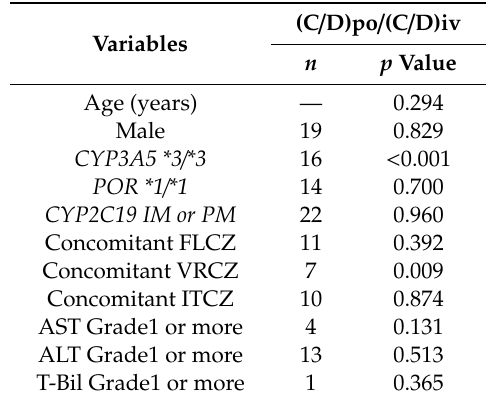
Table 5. Univariate logistic regression analysis of variables associated with an increase in tacrolimus (C / Dpo) / (C / Div) ( n = 33).